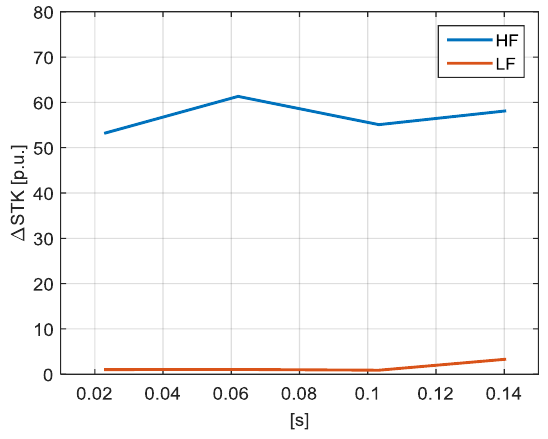
Figure 36. Case study 2: Δ STK at low-frequency (0 ÷ 2 kHz, red line) and at high-frequency (2 ÷ 150 kHz, blue line) obtained through Prony’s method.